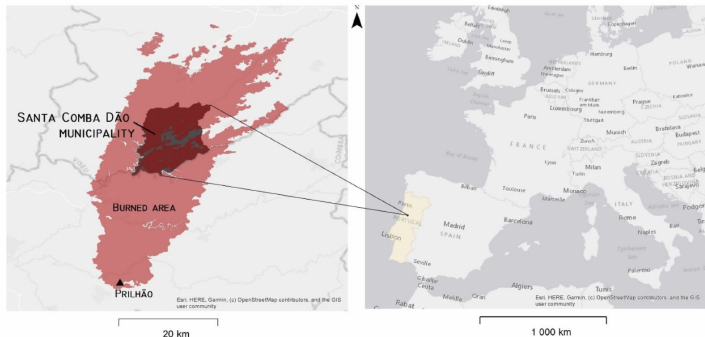
Figure 1. Santa Comba D ã o municipality and 15 October 2017 extreme